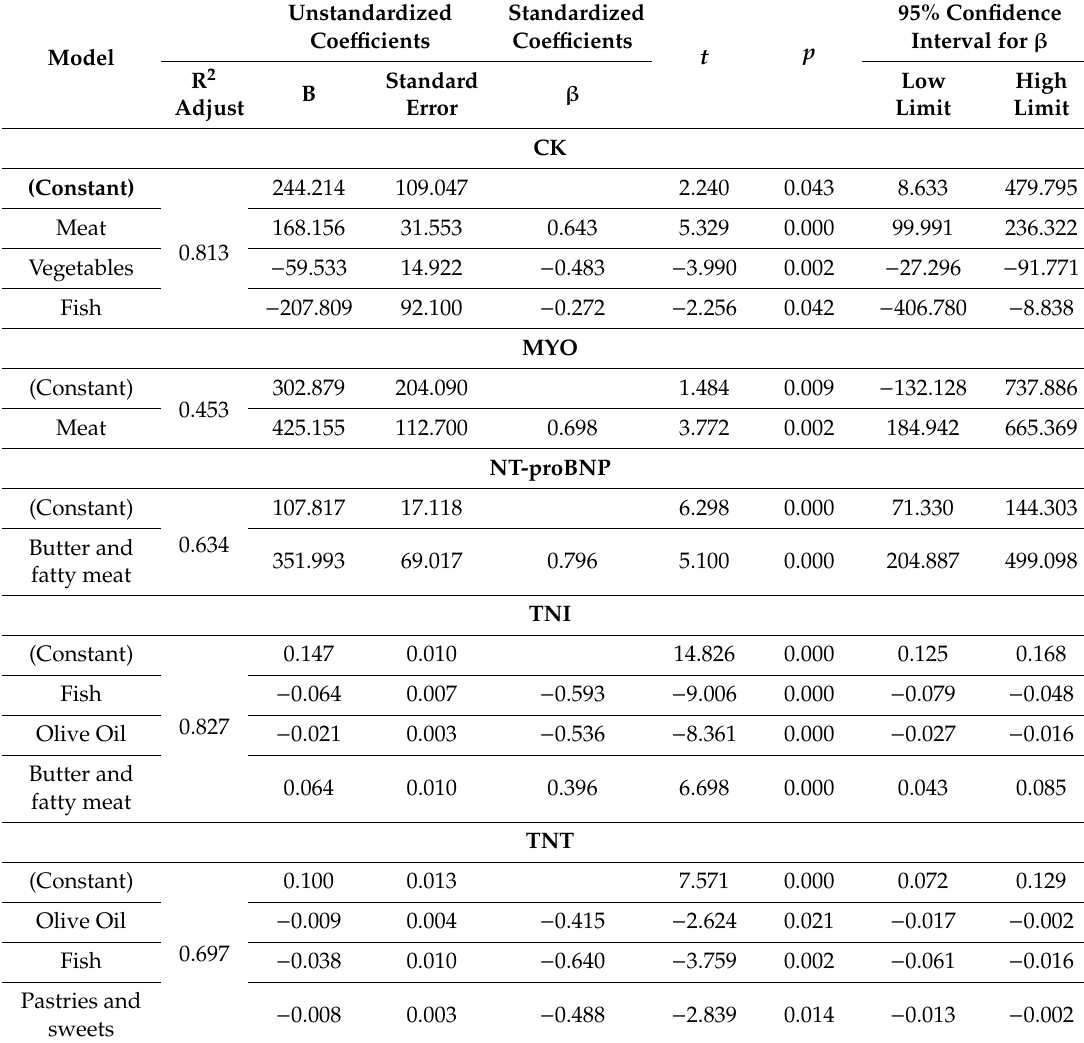
Table 6. Regression multivariate analysis with EIMD and EICS markers as the dependent variables and food groups as the independent